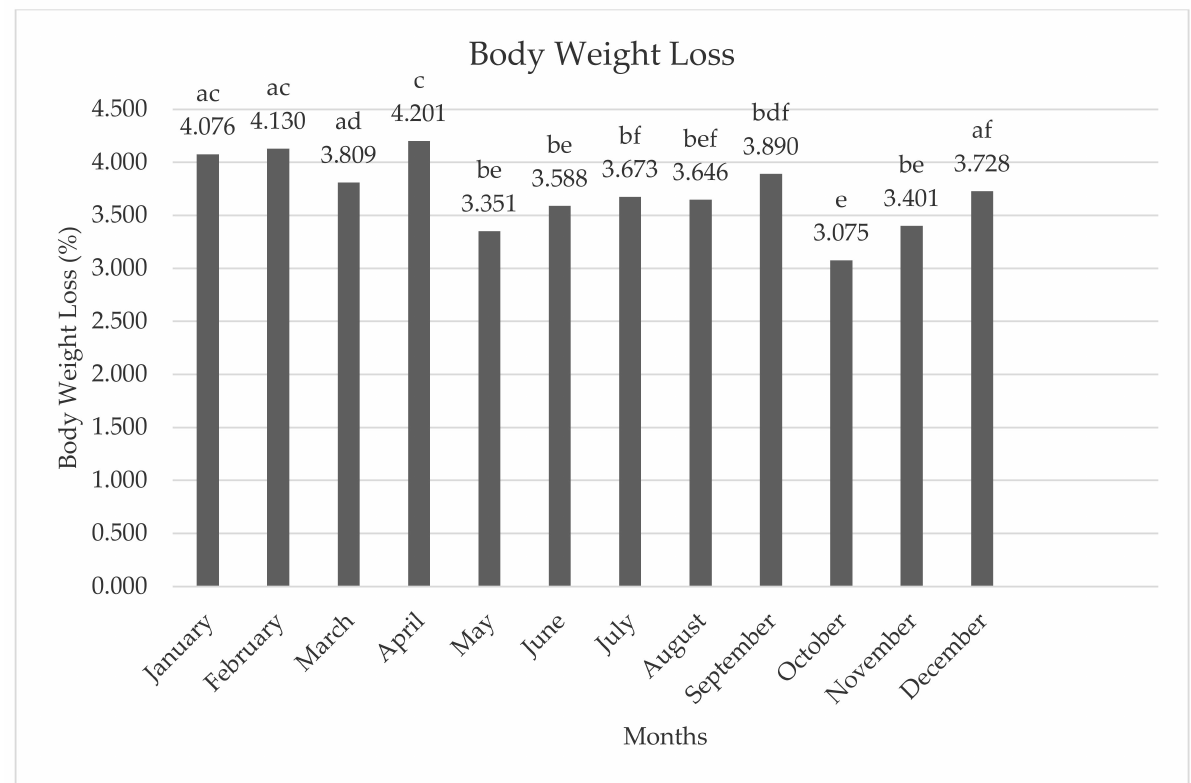
Figure 2. The average body weight loss of hens according to months. a – f ; different letters indicate statistical differences.